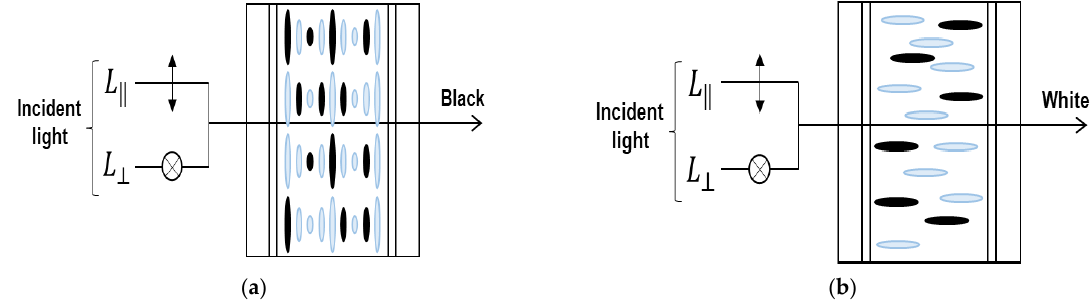
Figure 3. A switching window for the non-polarized mode transparent OLED cell using a Ch-LC layer with the dichroic dye: ( a ) Dark state and ( b ) Bright state.